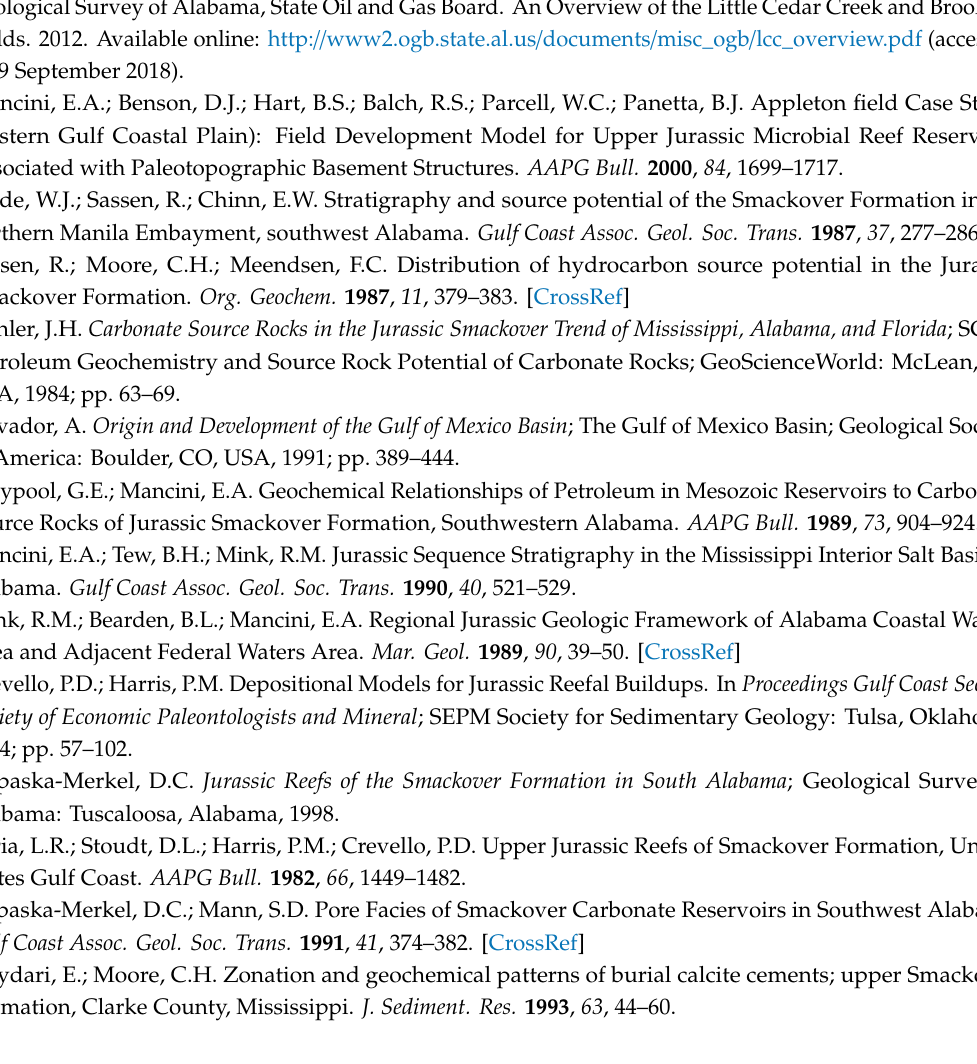
Table S1: XRF elements for Johnson-Stewart 32-12 #1; Table S2: XRF elements for Mary Godwin 31-3; Table S3: XRF elements for Cedar Creek Land and Timber 33-10 #1; Table S4: XRF elements for Cedar Creek Land and Timber 27-15 #1; Table S5: XRF elements for Benjamin 26-4; Table S6: XRF elements for McCreary 13-16; Table S7: XRF elements for Craft-Ralls 28-16 #1 WI; Table S8: XRF elements for Craft-Barrow 12-8